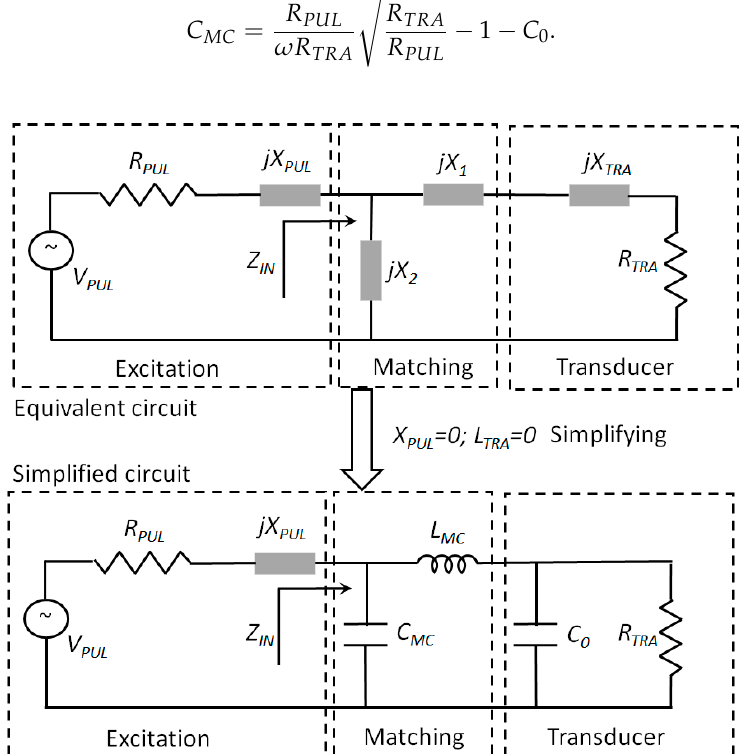
Figure 7. An equivalent circuit at series resonance being simplified assuming purely resistive output excitation and a low pass filter solution for electrical impedance matching circuit.